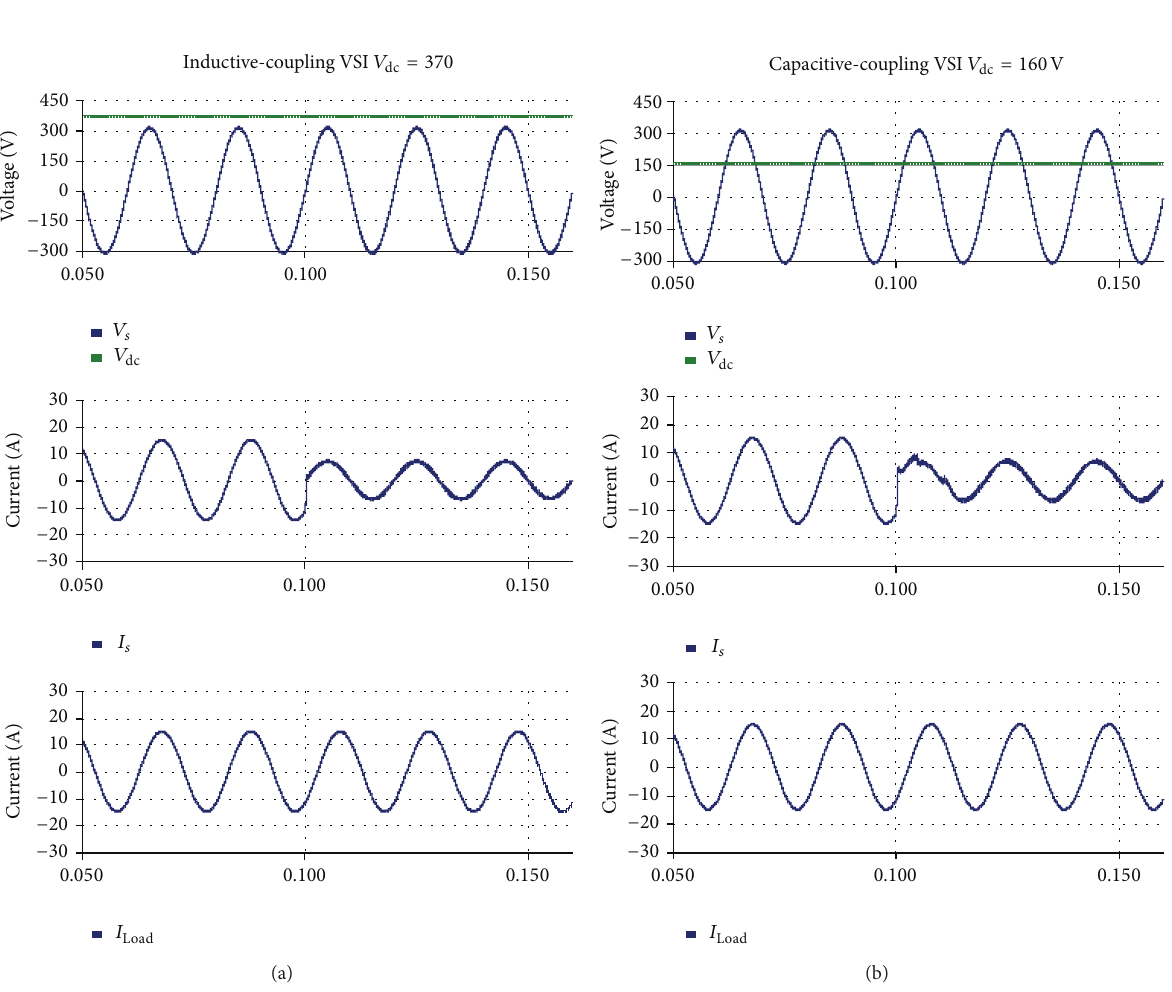
Figure 8: Simulation results without harmonic compensation: (a) inductive-coupling VSI and (b) capacitive-coupling